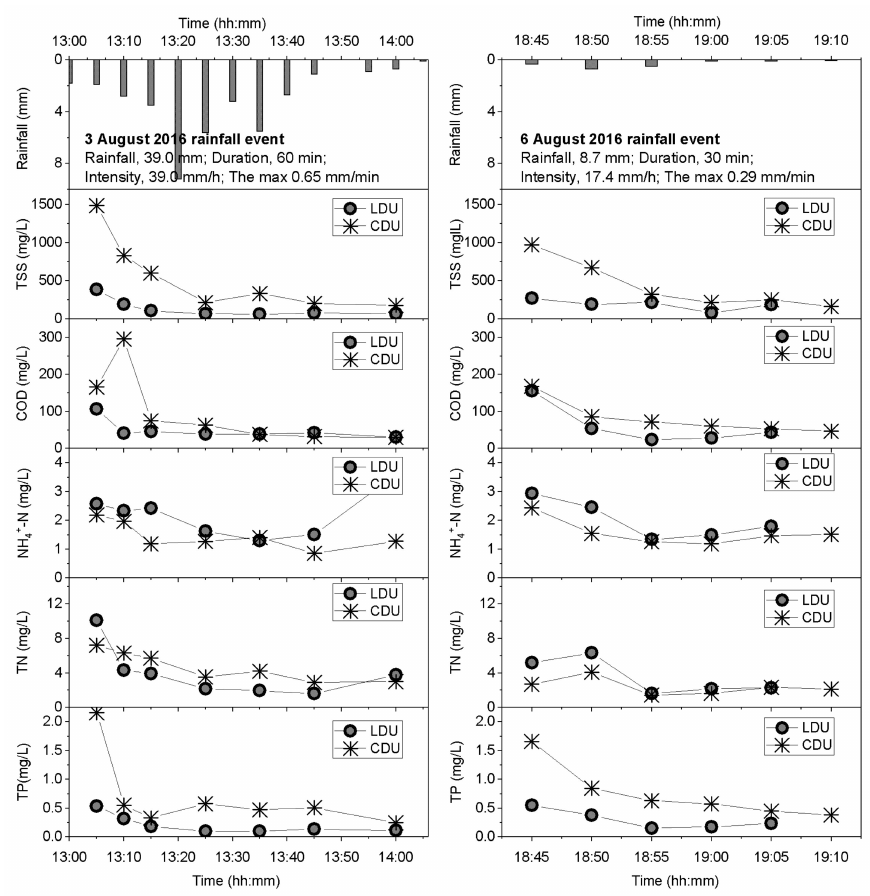
Figure 5. Variations of TSS and other pollutant concentrations during the rainfall-runoff process. LDU = LID residential drainage unit; CDU = conventional residential drainage